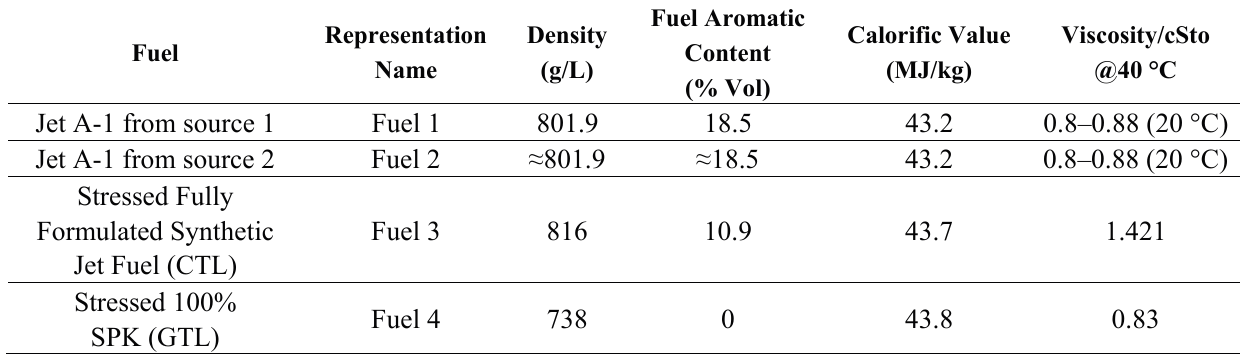
Table 1. Fuel names and basic specifications used in this